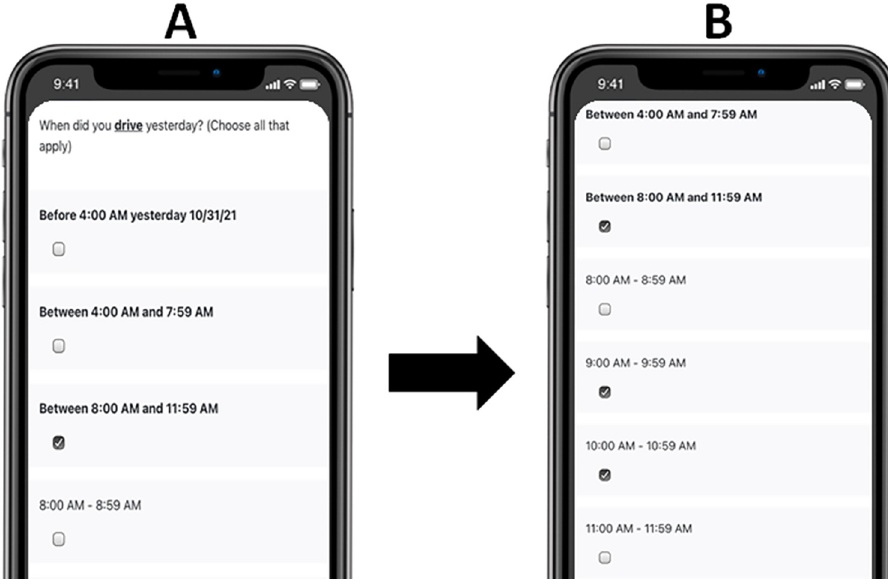
Fig 1. Example of daily measures assessing timing. Note: Participants first receive the screen shown in panel “A.” When a 4-hour period is chosen, below it 1-hour increment options appear as shown in panel “B.”.